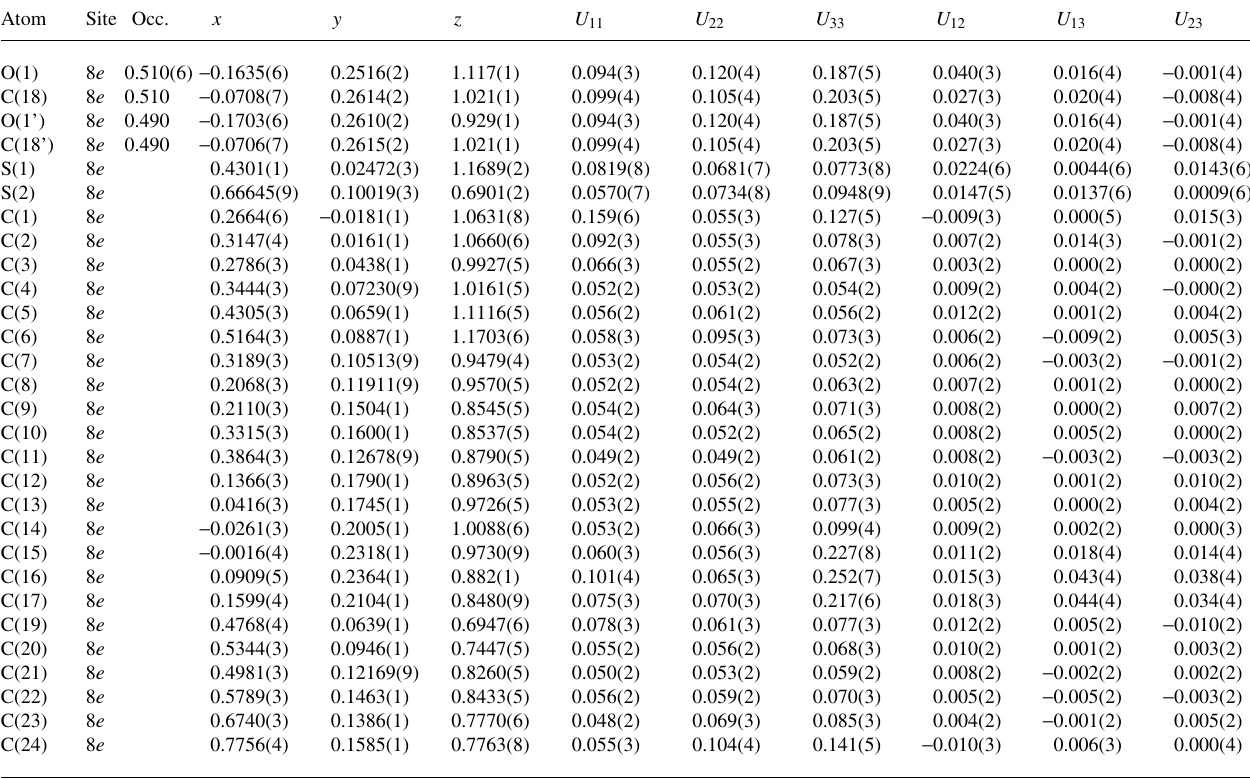
Table 3. Atomic coordinates and displacement parameters (in Å 2 ) .